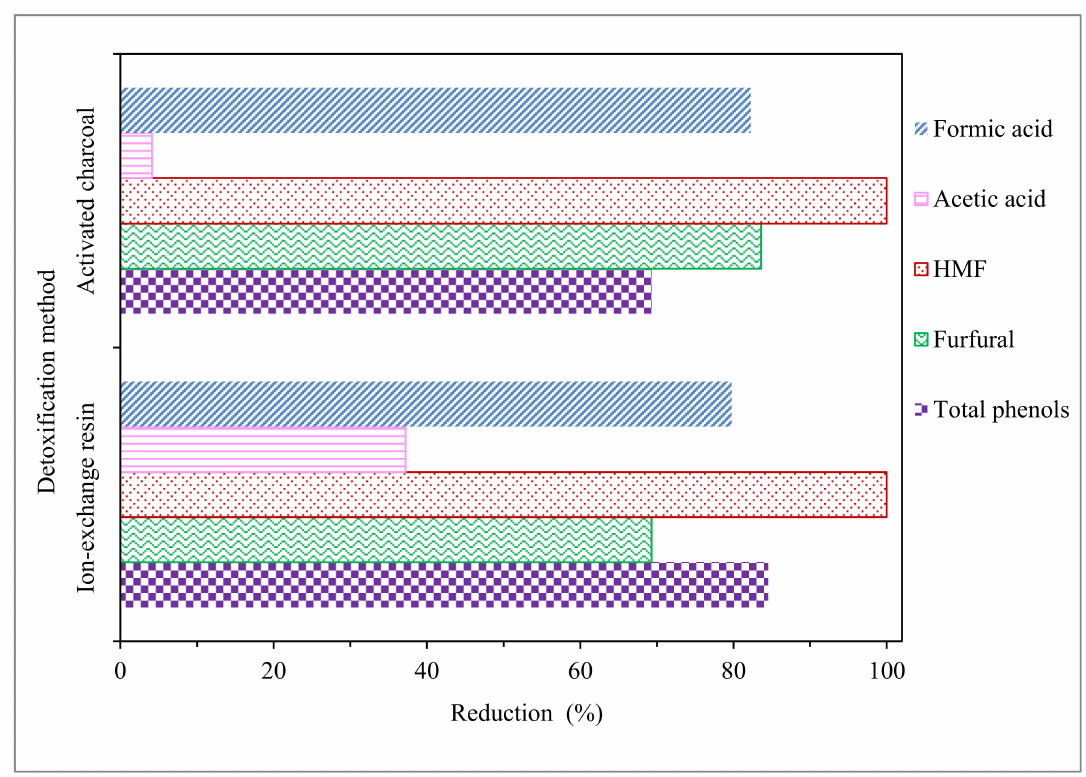
Figure 1. Removal percentages of total sugars and inhibitor compounds in the acid hydrolysate after diverse detoxification methods. HMF: